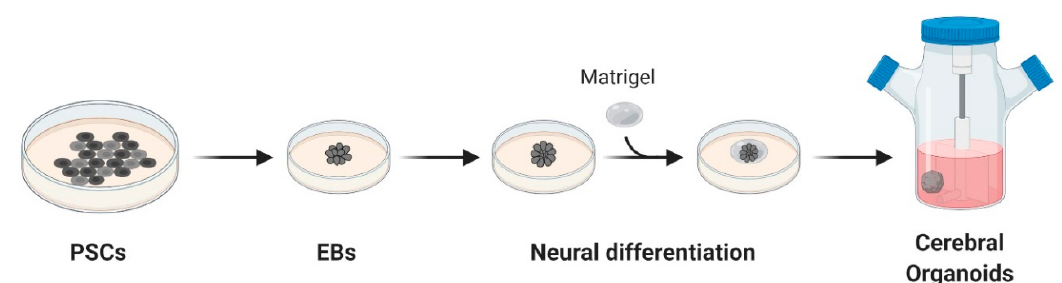
Figure 1. Schematic overview of cerebral organoids’ derivation. Cerebral organoids were obtained starting from pluripotent stem cells (PSCs) cultured as embryoid bodies (EBs) and successively differentiated to generate neuroectoderm. These 3D cultures, embedded in droplets of Matrigel, were then moved to a spinning-bioreactor containing differentiation media. Adapted from reference [61].